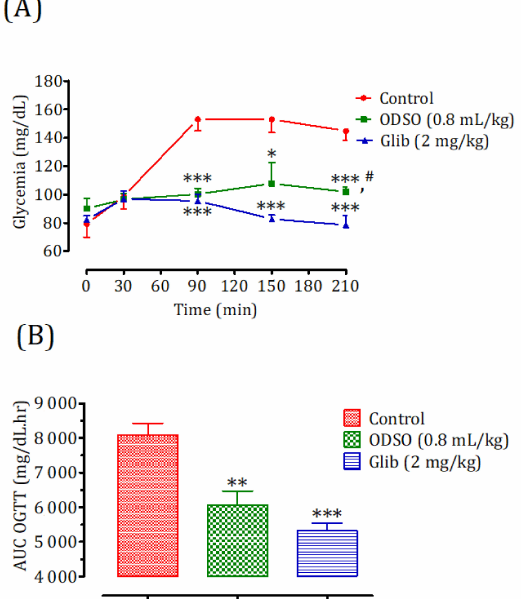
Figure 1. Changes in the basal blood D -glucose ( A ) and area under the basal blood D -glucose curves ( B ) in normal rats after administration of the tested products (ODSO and glibenclamide). ODSO: Opuntia dillenii seed oil. The values are the means ± SEM ( n = 6). ODSO: Opuntia dillenii seed oil. *** p < 0.01 in comparison with the control and ### p < 0.001 compared to the glib group. Glib: glibenclamide and AUC: area under the curve.